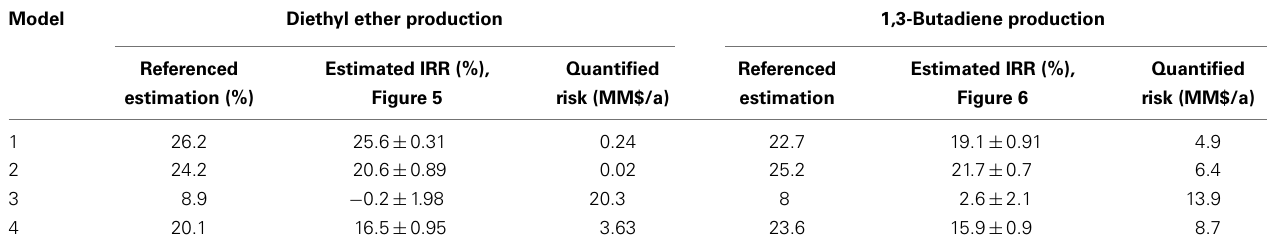
Table 13 | Risk analysis of the production of diethyl ether and 1,3-butadiene